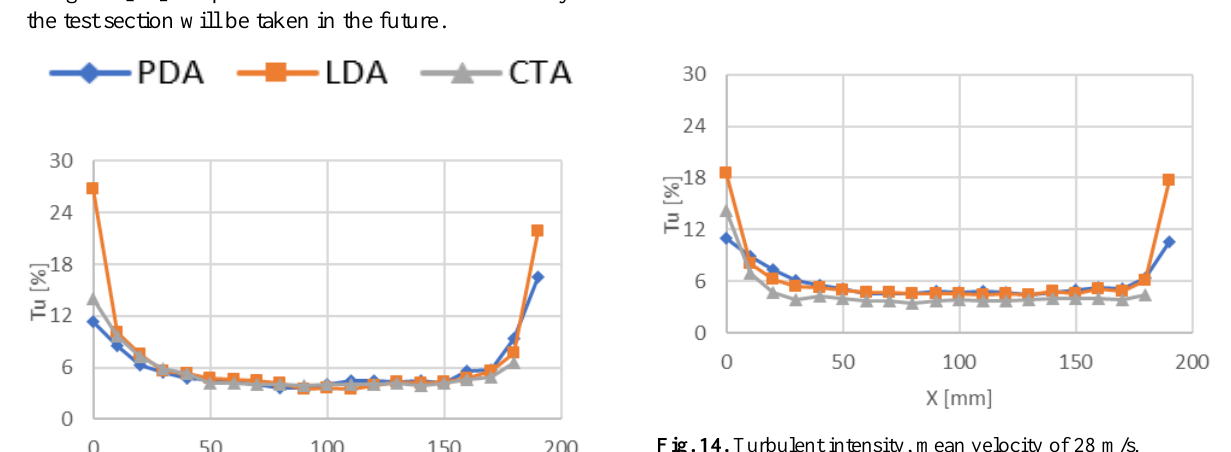
Fig. 14. Turbulent intensity, mean velocity of 28 m/s